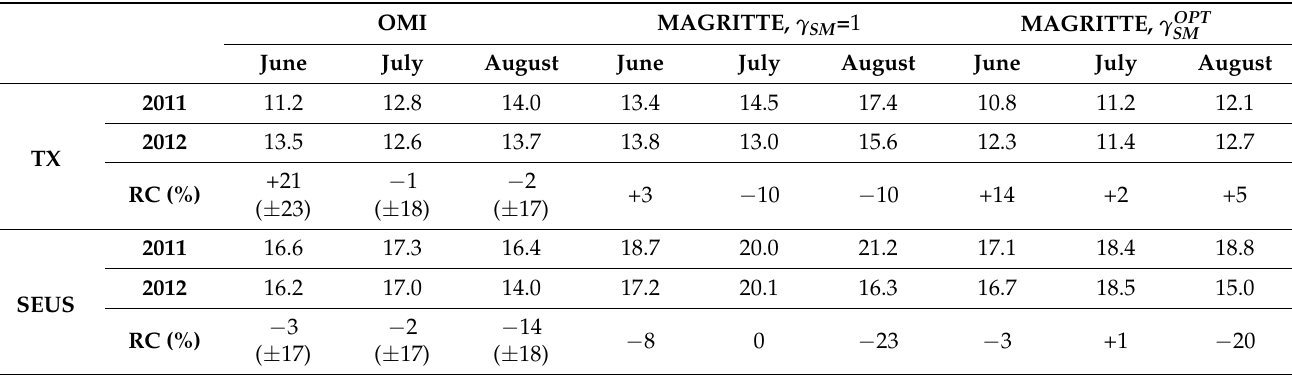
Figure 6. Absolute difference in monthly HCHO columns (10 15 molecules cm − 2 ) at 0.5 ◦ spatial resolution in the eastern U.S. between 2012 and 2011 during the summer (June–August) for OMI ( top row ), MAGRITTE, γ SM = 1 ( middle row ) and MAGRITTE, γ OPT ( bottom row ). The black boxes SM mark the areas selected for the regional assessments in Texas (TX: 26–34 ◦ N, 94–100 ◦ W) and south- eastern U.S. (SEUS: 29–39 ◦ N, 75–93 ◦ W). The stippling indicates the grid cells where the differences in OMI HCHO columns is not statistically different from zero at the 68% confidence level (1 σ ), based on estimated random errors of the OMI retrieval. Table 2. Monthly HCHO columns (10 15 molecules cm − 2 ) in JJA 2011 and 2012 averaged over the Texas (TX) and southeast U.S. (SEUS) regions, and relative change (RC) between monthly averages in years 2012 relative to 2011 expressed in percentage. Values are given for OMI observations and for MAGRITTE, γ SM = 1 and MAGRITTE, γ OPT . The RC in OMI HCHO averaged columns is provided SM with the uncertainty based on the propagation of random errors of OMI